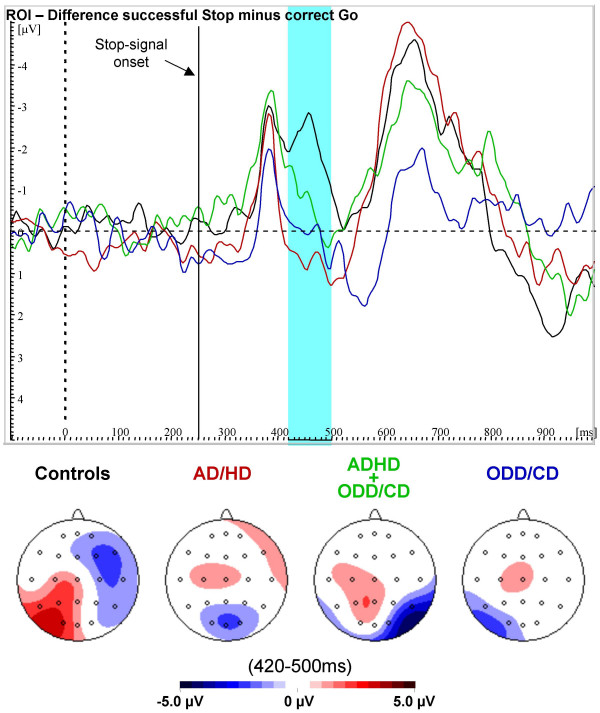
Difference ERPs (successful Stop minus correct Go). Difference waves and spline-interpolated difference maps between event-related potential grand means of successful Stop-correct Go-trials in the region of interest for normal controls (black), AD/HD (red), AD/HD+ODD/CD (green) and ODD/CD (blue). A clear Stop-signal N200 is present only for normal controls.